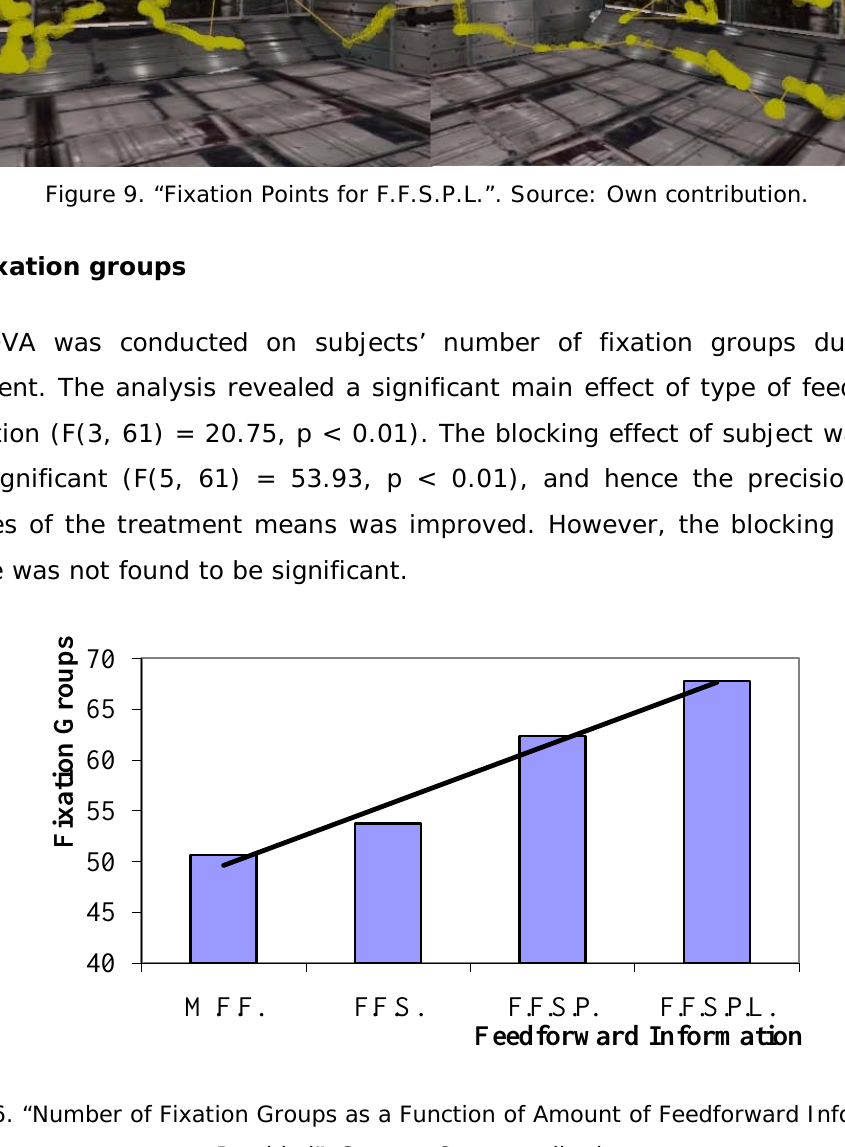
Figure 6. “Number of Fixation Groups as a Function of Amount of Feedforward Information Provided”. Source: Own